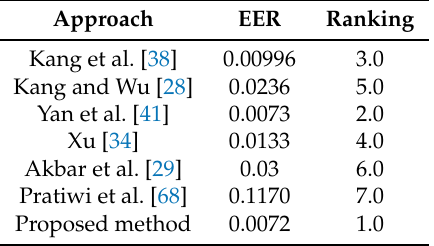
Table 10. Rankings of different approaches based on EER results on CASIA-MS-PalmprintV1